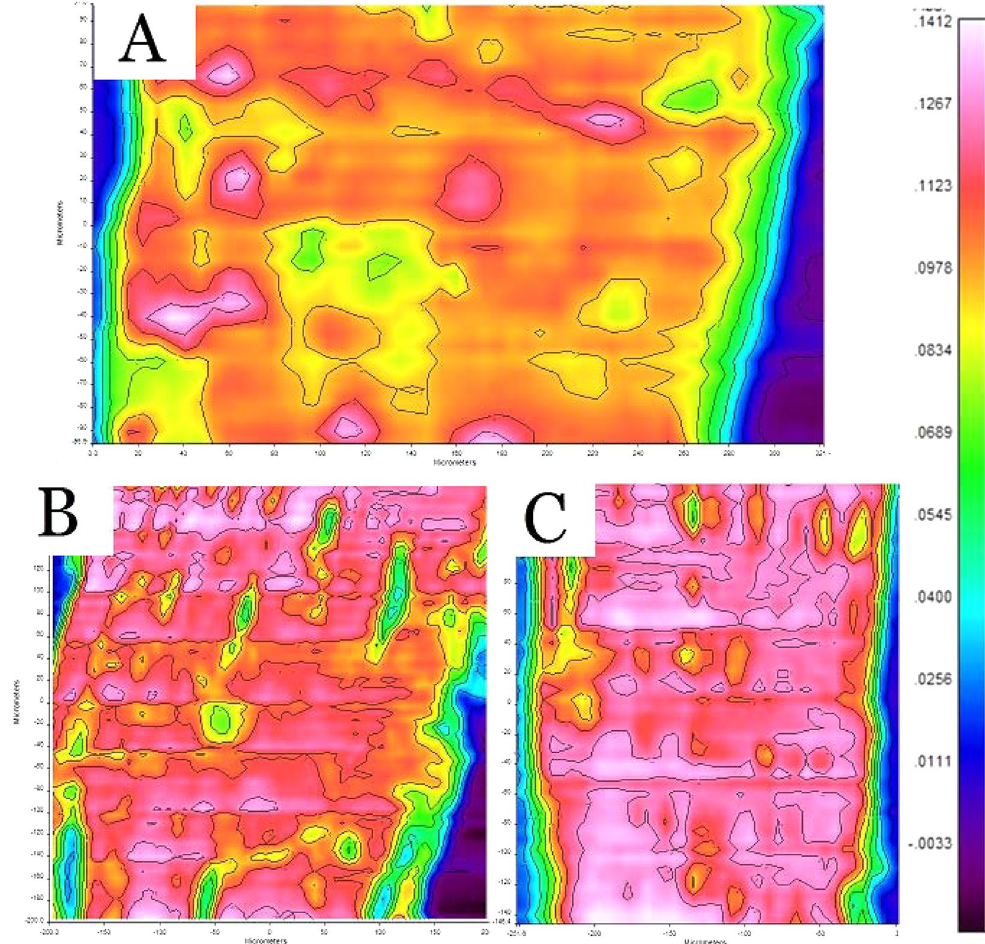
Figure 2. Cellulose infrared microspectral images. ( A ) raw kenaf fiber bundle, ( B ) semi-degummed fiber bundle and ( C ) degummed fiber